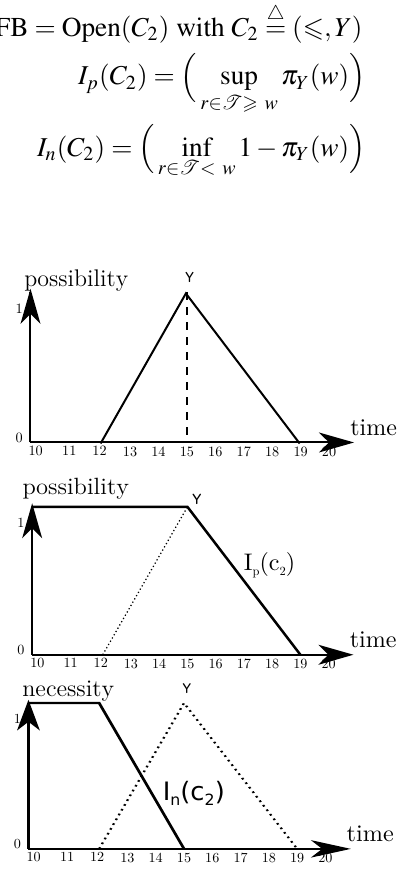
Fig. 5. Possibility distribution for Y , and possibility and necessity measures for the open ill-known point, X